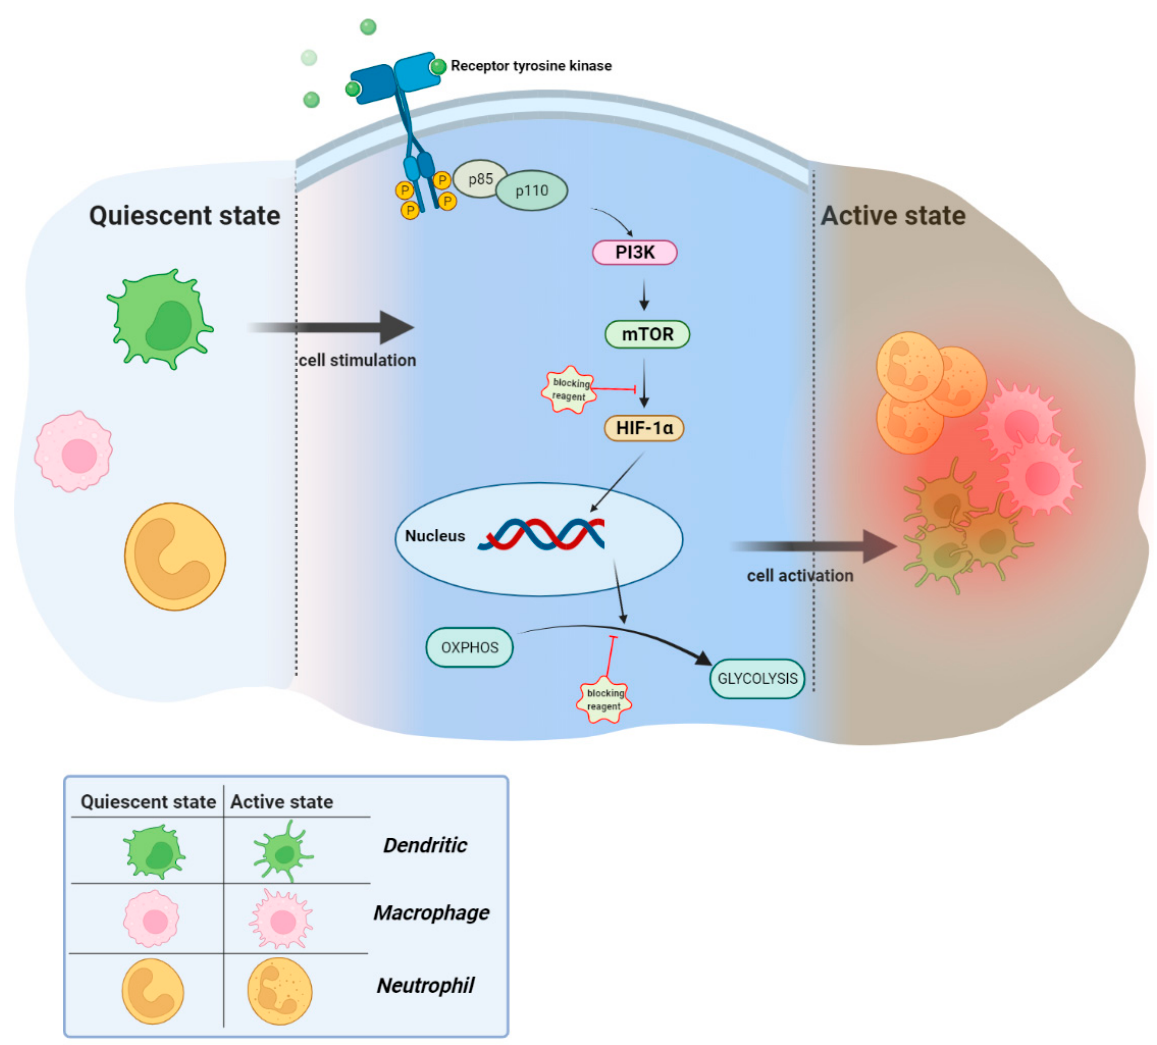
Figure 2. Inhibition of mTOR and/or OXPHOS-glycolysis switching. Created with BioRender.com (accesed on 22 April